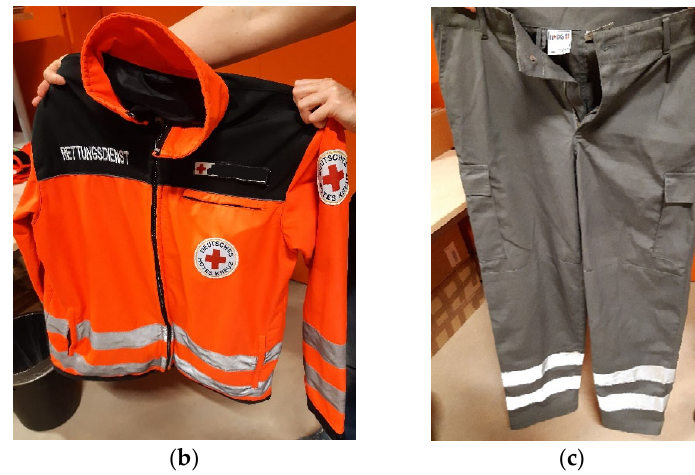
Figure 1. Photos of the investigated workwear. ( a ) Paramedical trousers; ( b ) paramedical jacket; ( c ) civil protection trousers.